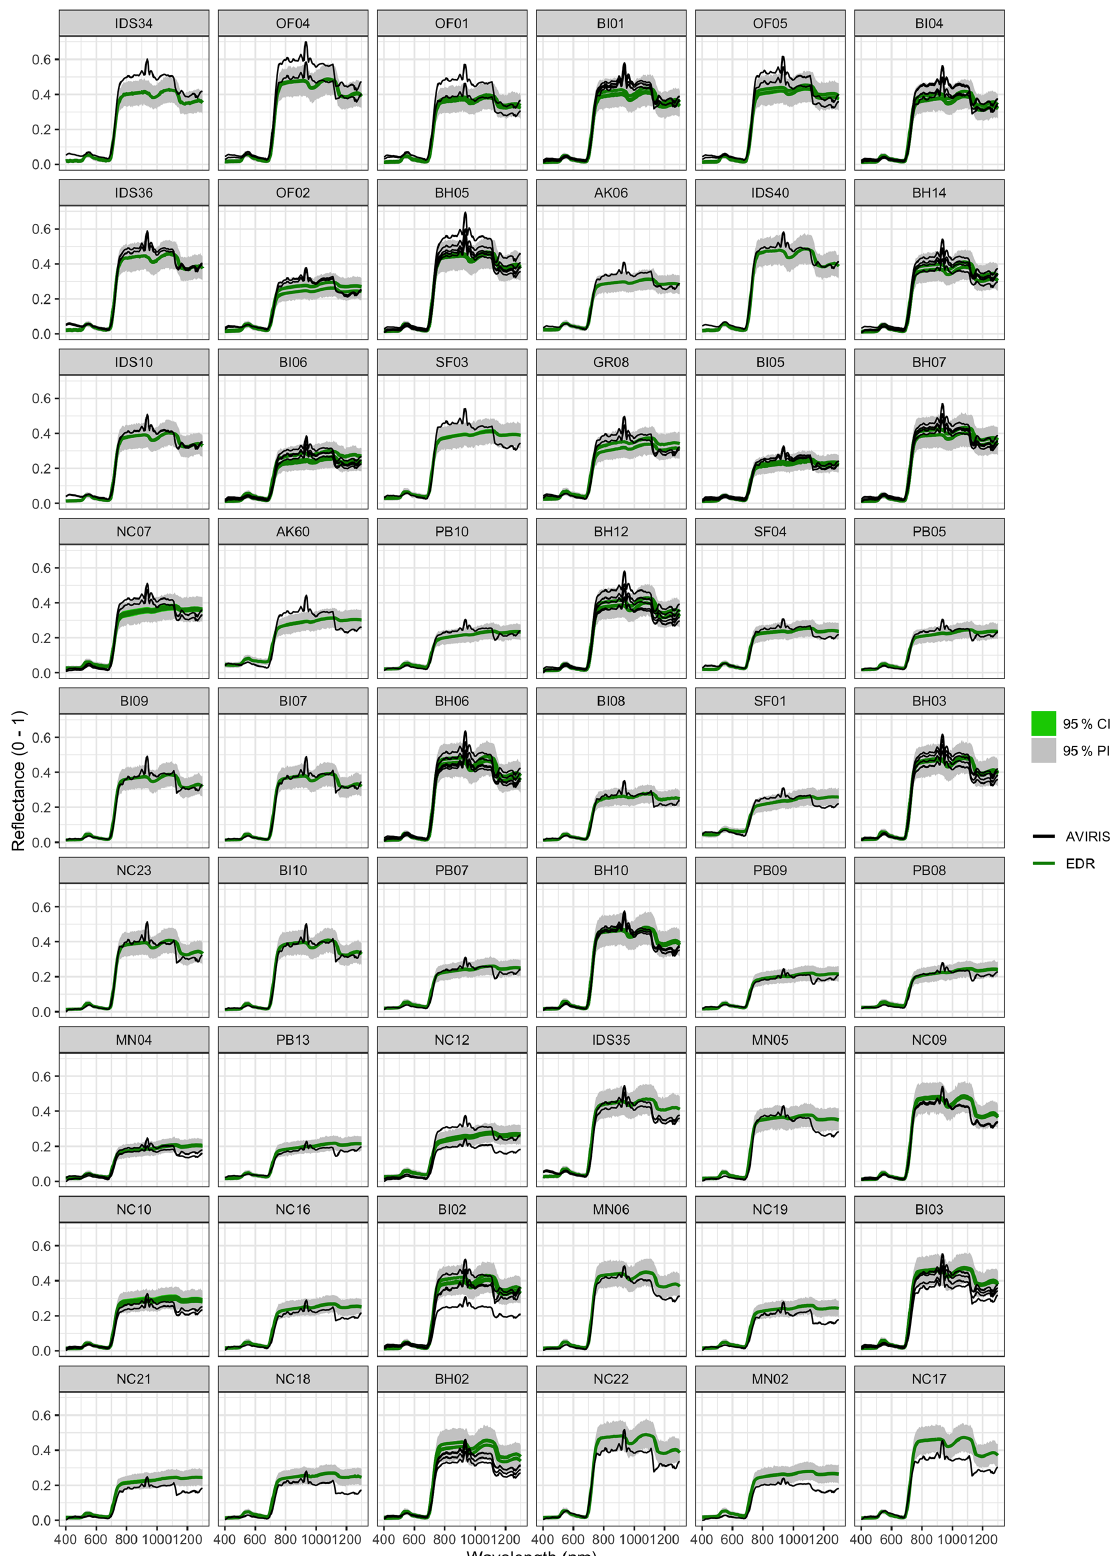
Figure A5. Comparison between AVIRIS-observed (black) and surface reflectance for each site used in the calibration. Sites are sorted in order of decreasing mean difference between observed and EDR-predicted reflectance (largest underestimates first; largest overestimates